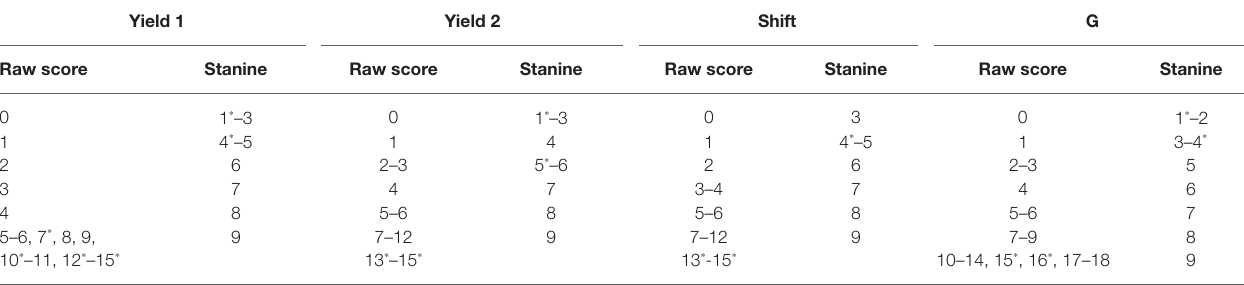
TABLE 4 | Raw scores and stanine norm for the Yield 1 scale, the Yield 2 scale, the Shift scale, and the scale score G ( N = 560).